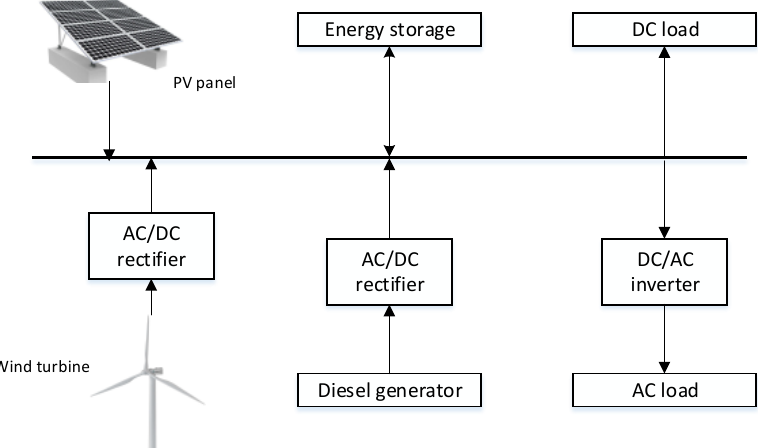
Figure 1. Off-grid HRES